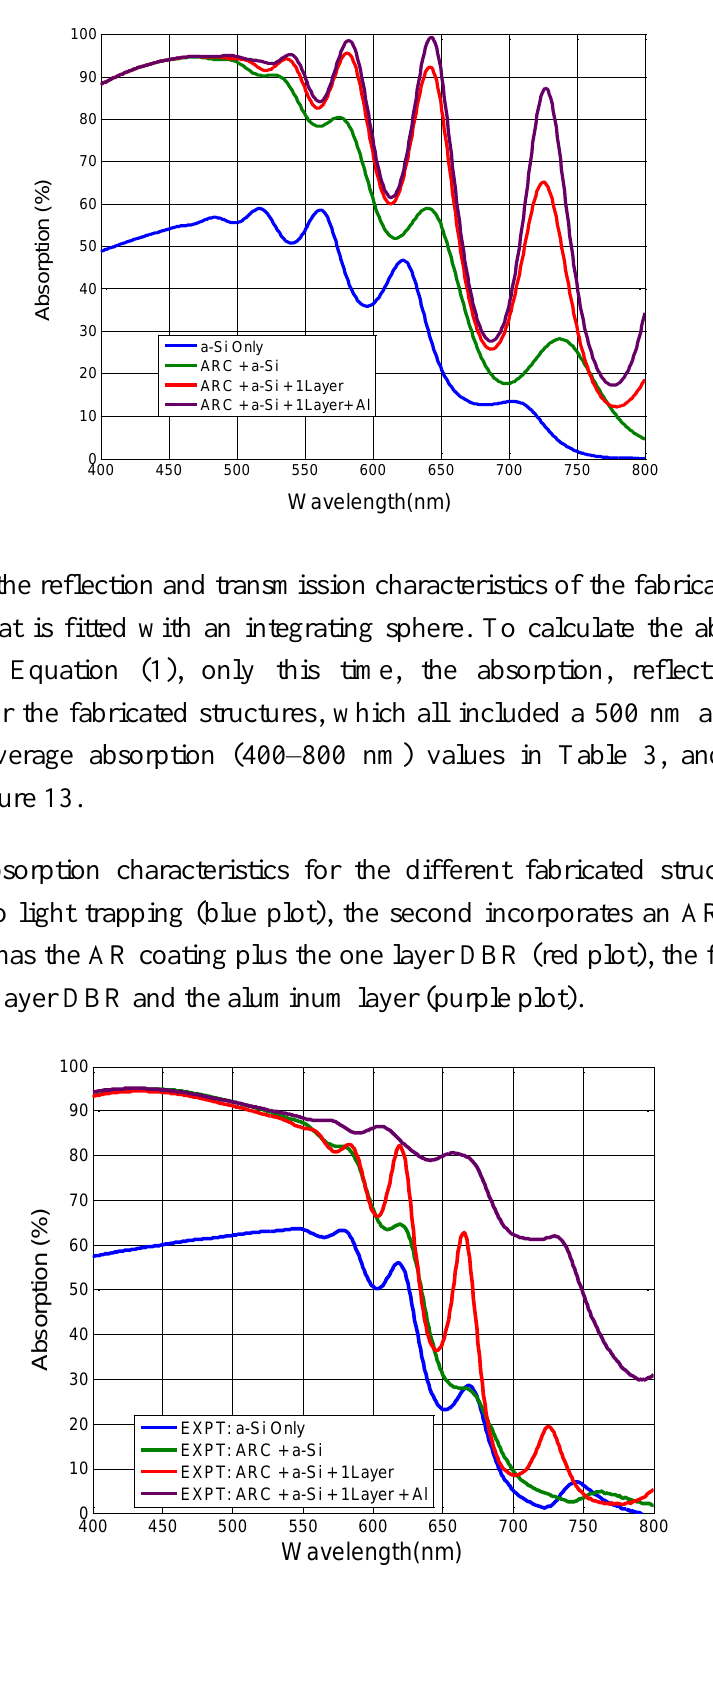
Figure 12. Simulation of absorption characteristics of the different structures. The first structure has no light trapping (blue plot), the second incorporates an AR coating (green plot) , the third has the AR coating and the one layer DBR (red plot), the final one has the AR coating, 1 Layer DBR and the aluminum layer (purple plot).